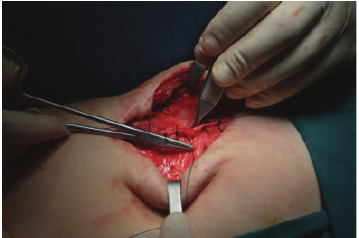
Figure 4: The hypoplastic fascial margins were stitched together, completely covering the mesh according to normal anatomic rela-